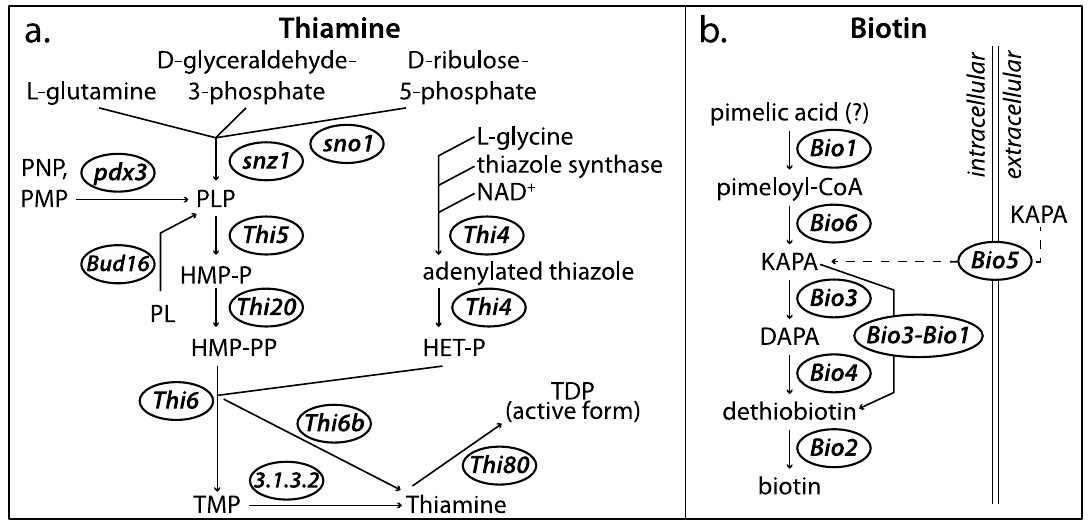
Figure 5. Biosynthesis pathway for the B vitamins thiamine ( a ) and biotin ( b ) in Saccharomyces cerevisiae . Figure based on Perli et al. (2020) [129].